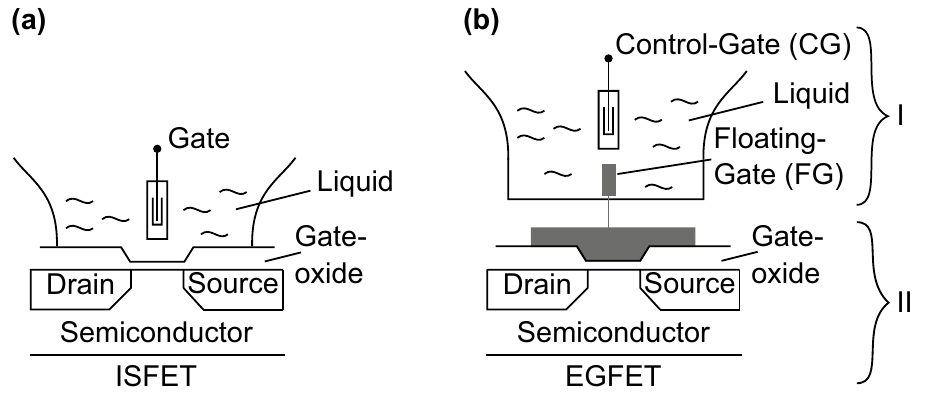
Figure 4. Schematic of an ( a ) ISFET and an ( b ) EGFET physically separated into (I) sensing area and (II) transducer (field-effect transistor) but electrically connected by the floating-gate electrode (FG) 23